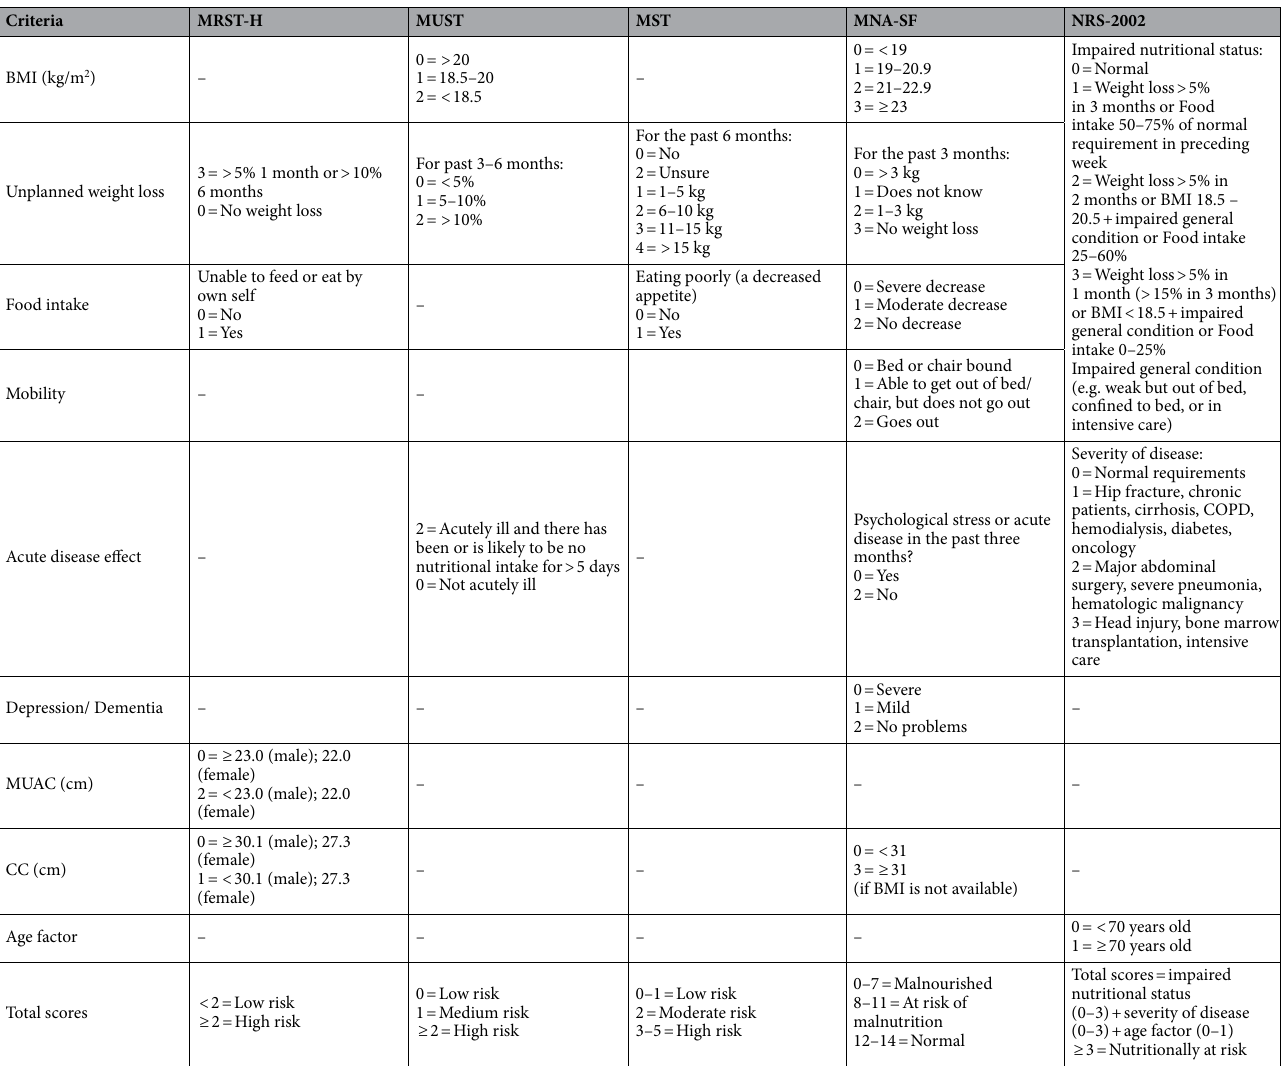
Table 1. Screening criteria for different malnutrition screening tools. Source : Tan et al. 15 , Ferguson et al. 18 , Todorovic and Elia 19 , Rubenstein et al. 20 , Kondrup et al. 16 . MRST-H Malnutrition Risk Screening